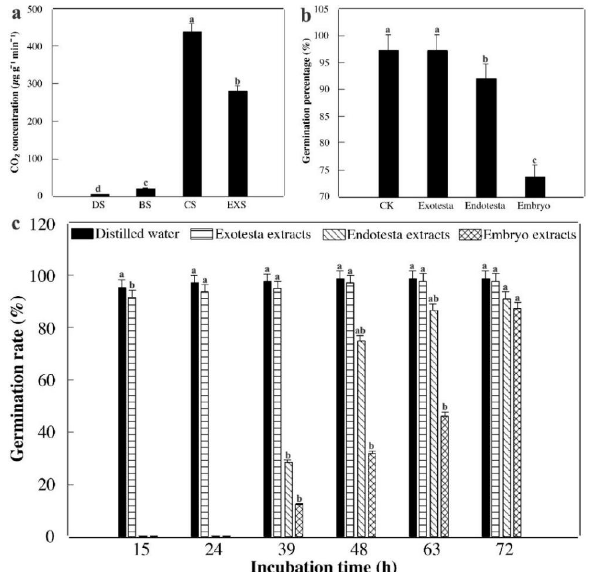
Figure 7. Variation in the respiration rate of Chinese pistache seeds under different treatments ( a ). Germination percentage of cabbage seeds under different treatments ( b ). CK, Exotesta, Endotesta, and Embryo mean nothing, exotesta, endotesta, and the embryos of Chinese pistache seeds laid on the bottom of the Petri dishes, respectively. Variations in the germination rate of cabbage seeds under different treatments with the increasing incubation time ( c ). Distilled water, exotesta extracts, endotesta extracts, and embryo extracts of Chinese pistache seeds were added to Petri dishes with filter papers to cultivate cabbage seeds. Different letters over bars indicate significant differences.